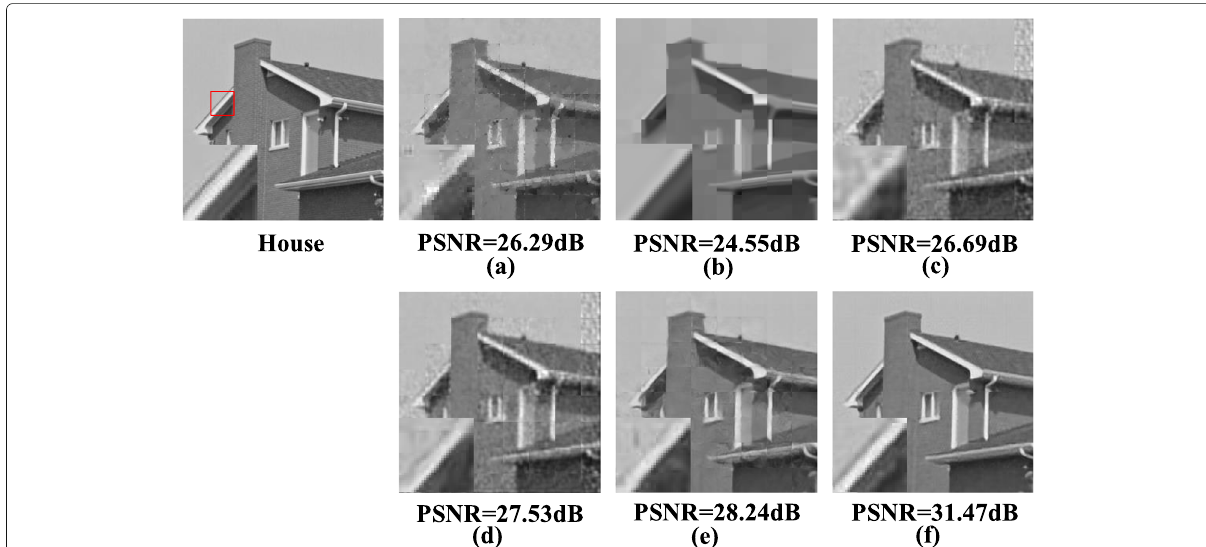
Fig. 9 The reconstruction results of House at the measurement rate of 0.1 without BM3D. a TVAL3. b DAMP. c ReconNet. d DR 2 -Net. e CSRNet. f ASRNet